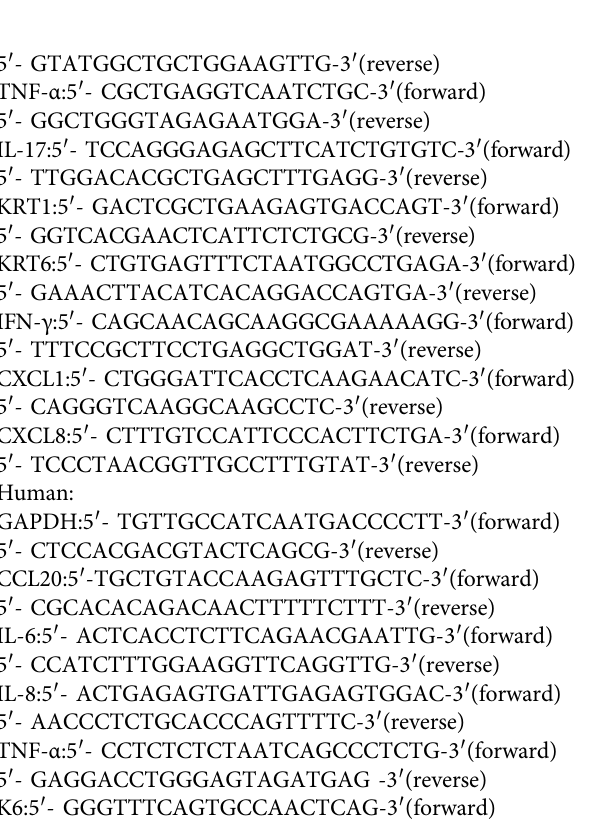
Frontiers in Bioengineering and Biotechnology |